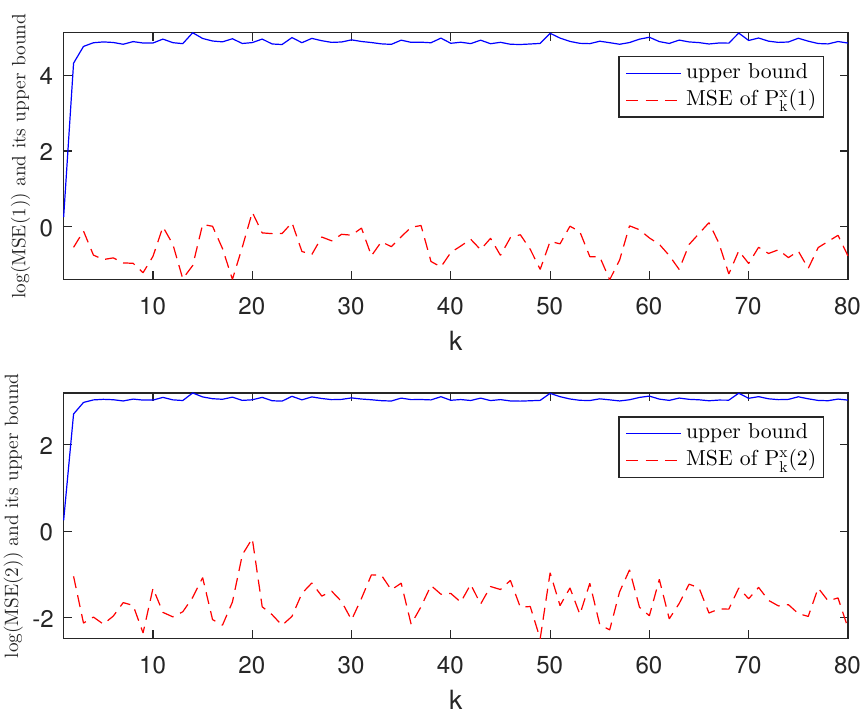
Figure 4. Log(MSE x Figure 4. Log(MSE x